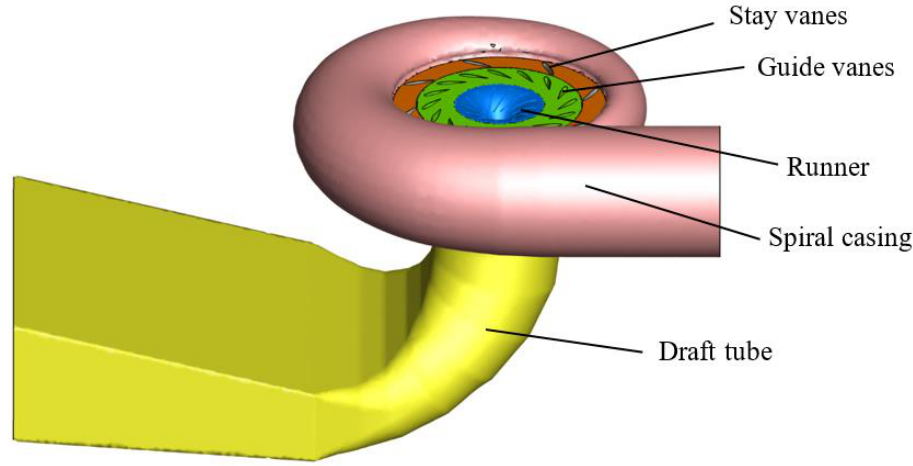
Figure 2. Three-dimensional perspective view of the turbine model.